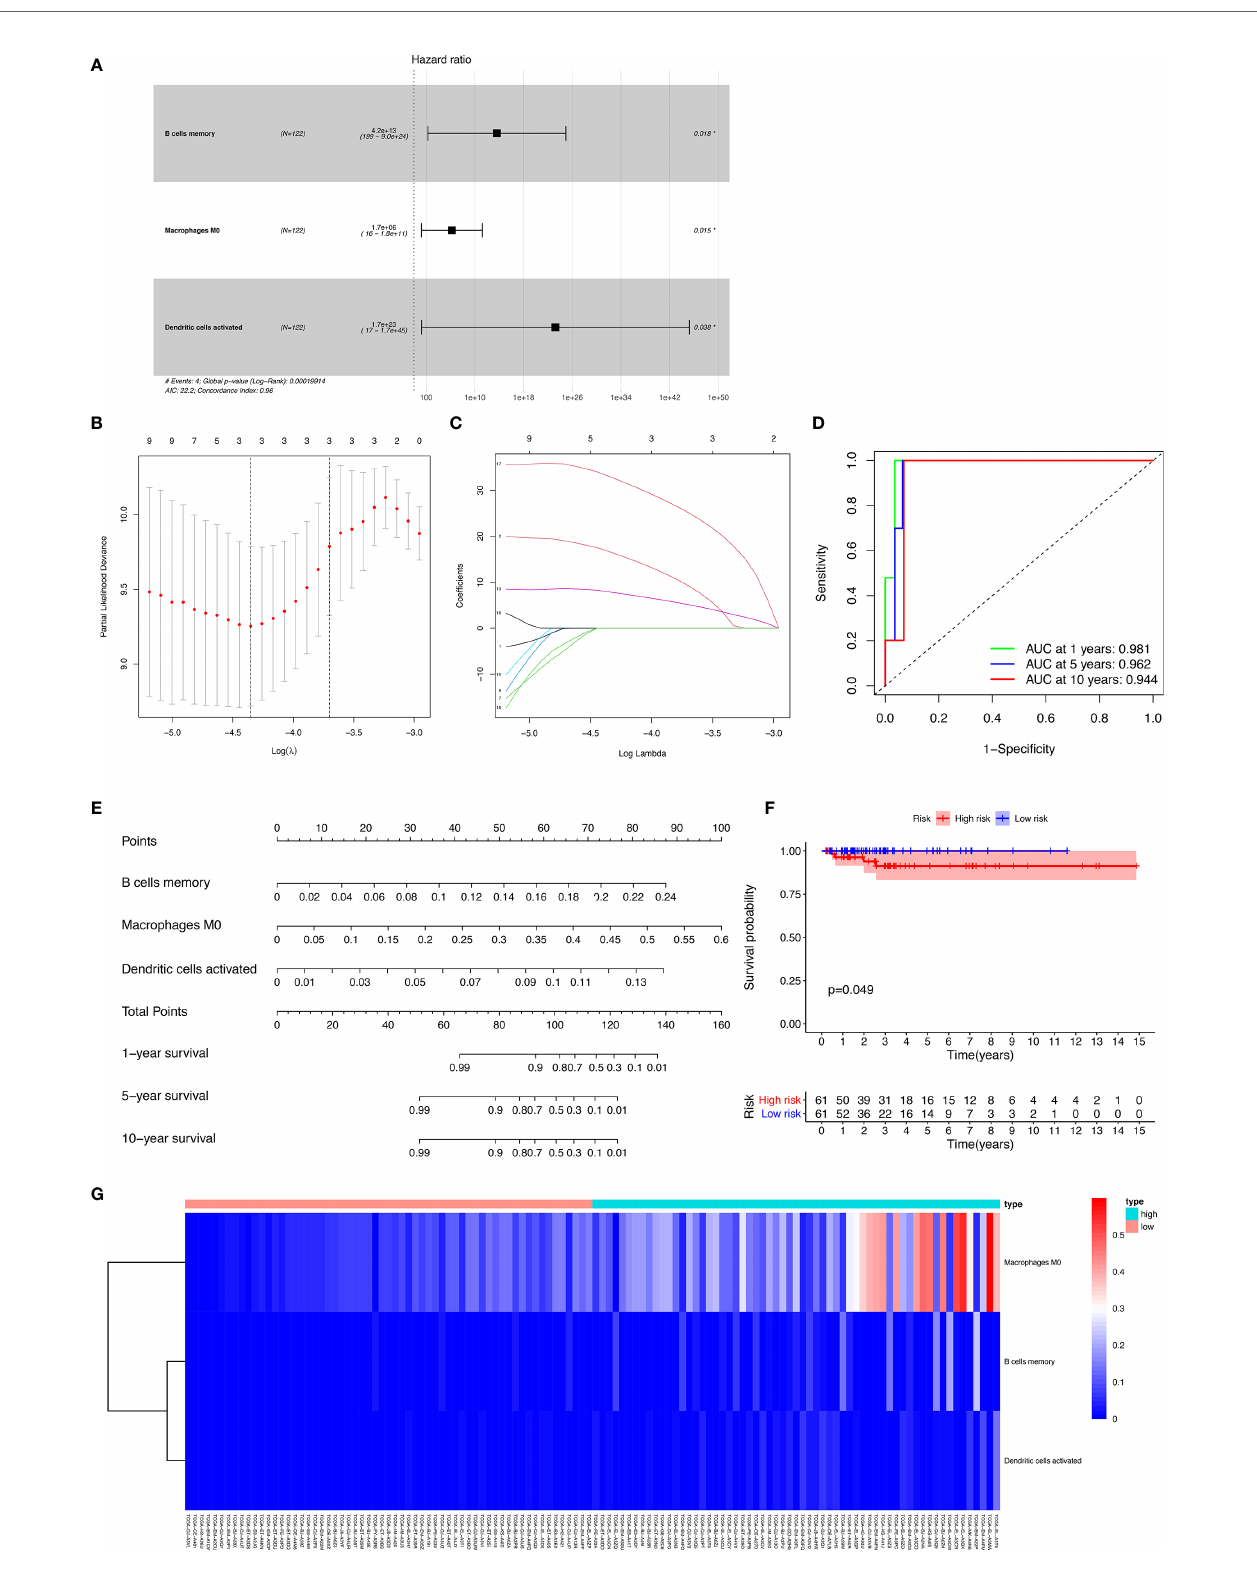
FIGURE 6 | The results of the Lasso regression revealed three immune cells that were key members and were integrated into a new multivariable model (A – C) ; the ROC demonstrated the nomogram ’ s good accuracy and concordance (D) ; constructed nomogram based on immune cells (E) ; the result of Kaplan-Meier analysis immune cells (F) ; the heatmap of the three immune cells in the Cox regression model (G)